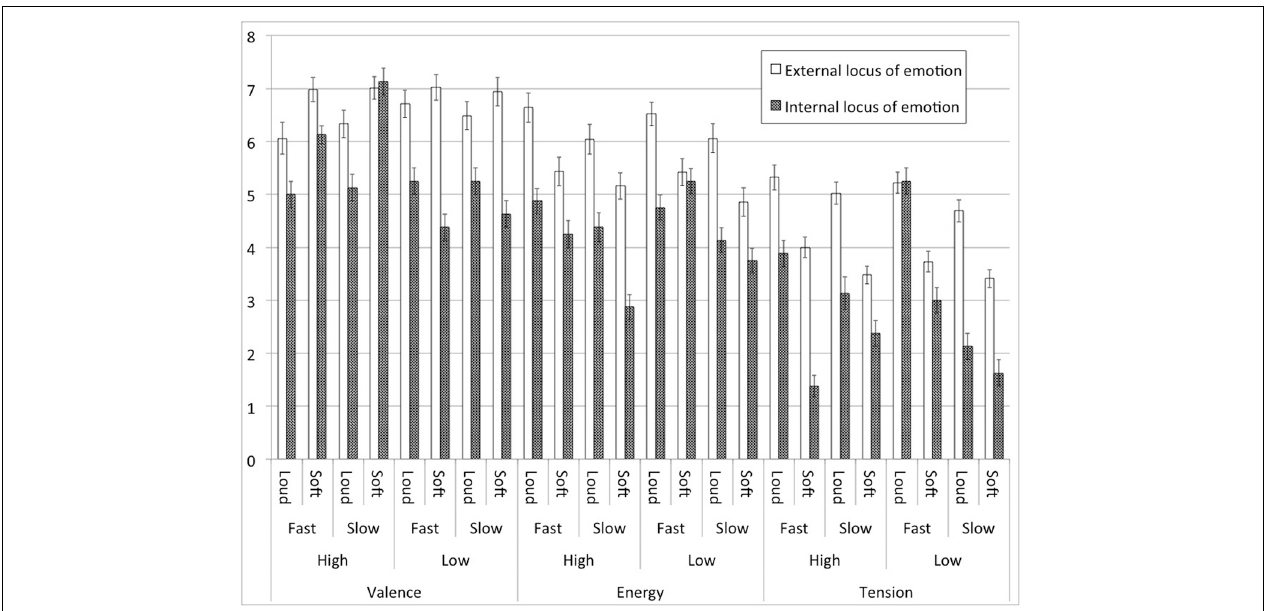
FIGURE 1 | Collation of data from two experiments (Ilie and Thompson, 2006, 2011, Experiment 1) comparing external and internal locus results across the combinations of independent variables—intensity (loud, soft), rate (fast, slow) and pitch (high, low)